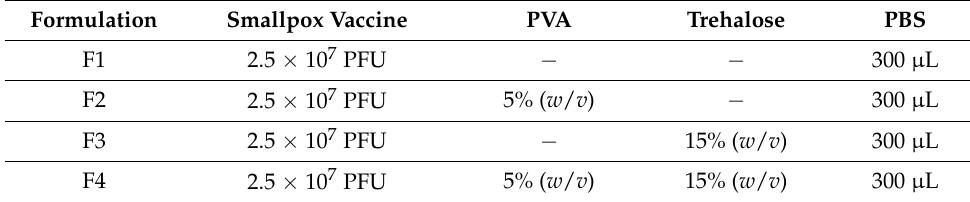
Table 1. Composition of coating solutions. Formulation